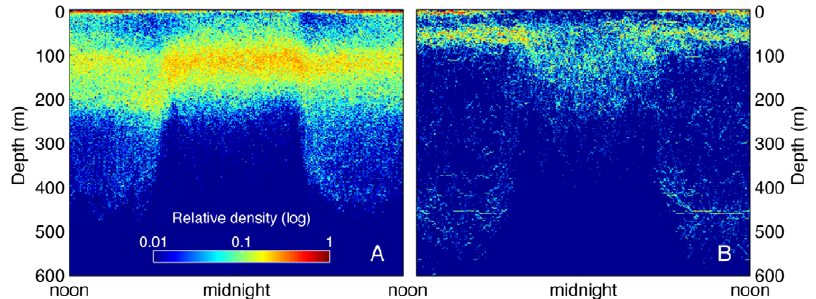
Figure 5. Differences in white shark behavior categorized as ‘ROD’ (rapid oscillatory diving) in the Cafe´ (a) and in Hawaii (b). High- resolution time and depth data were corrected for local time and aggregated by cluster over a 24-hour period. The relative density of data (log scale) is shown on a gridded surface. Clustering analysis placed most ROD in the Cafe´, but some occurred in Hawaii. However, the high vertical swimming speed characteristic of ROD in the Cafe´ was not present in Hawaii. While the overall depth distribution was similar there were clear differences apparent at time-scales below the cluster data bin size (24 hrs) including a strong daytime density band around 50 m in Hawaii. These differences illustrate that the ROD behavior in the Cafe´ is unique.